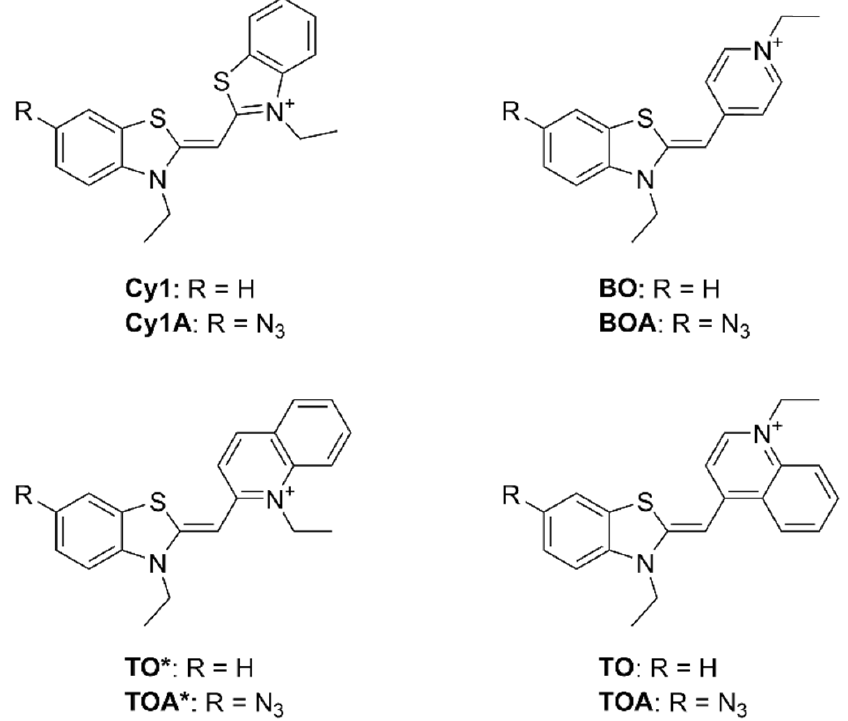
Figure 1. Structures of Cy1, BO , TO*, and TO frames, and their azide modified derivatives.